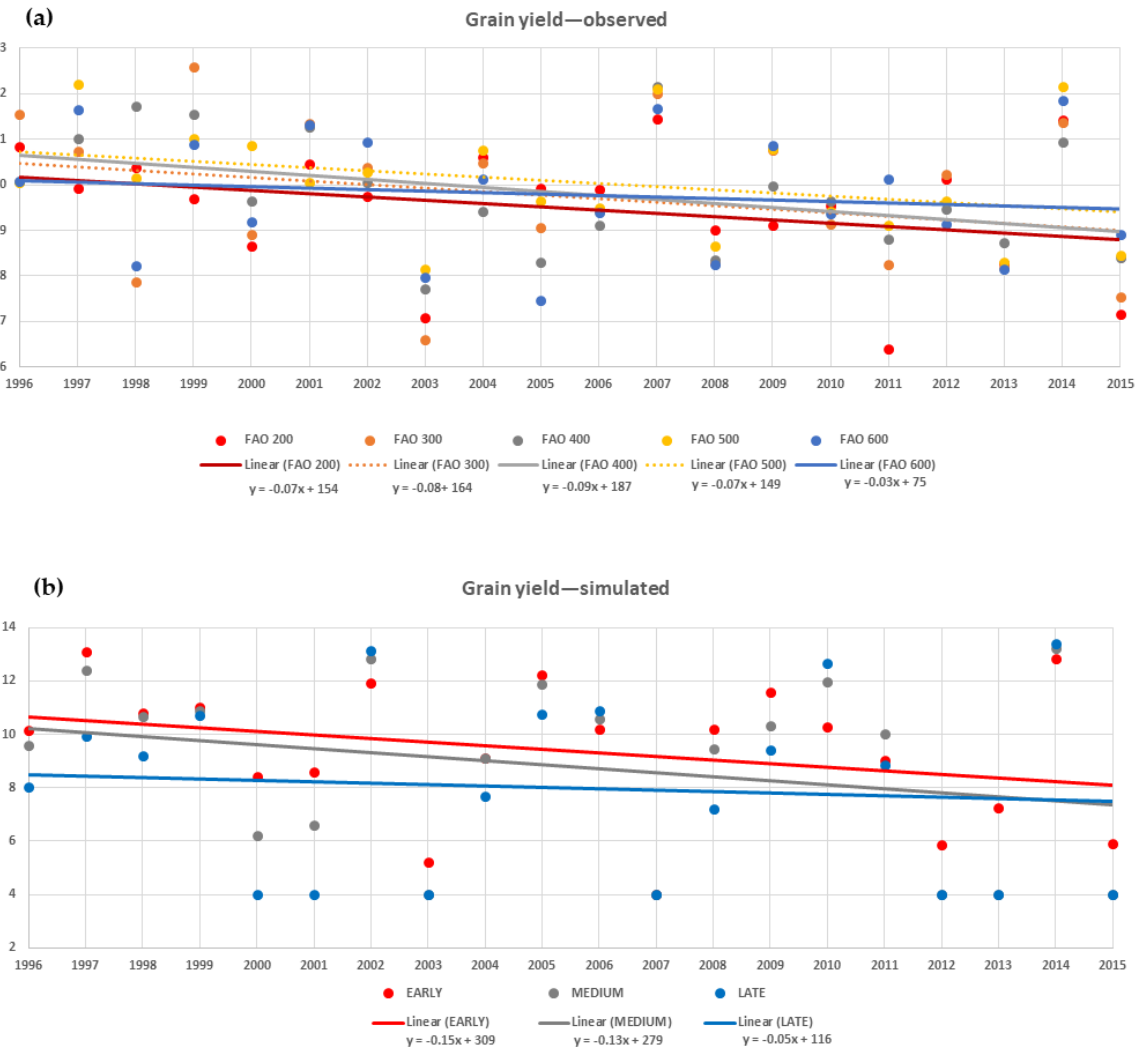
Figure 3. Grain yield trend during the period of 1996 to 2015 in Rugvica near Zagreb, Croatia in maize hybrids differing in maturity groups according to: ( a ) observed data in the experiment (FAO 200–FAO 600) and ( b ) APSIM simulated data (early–medium–late).